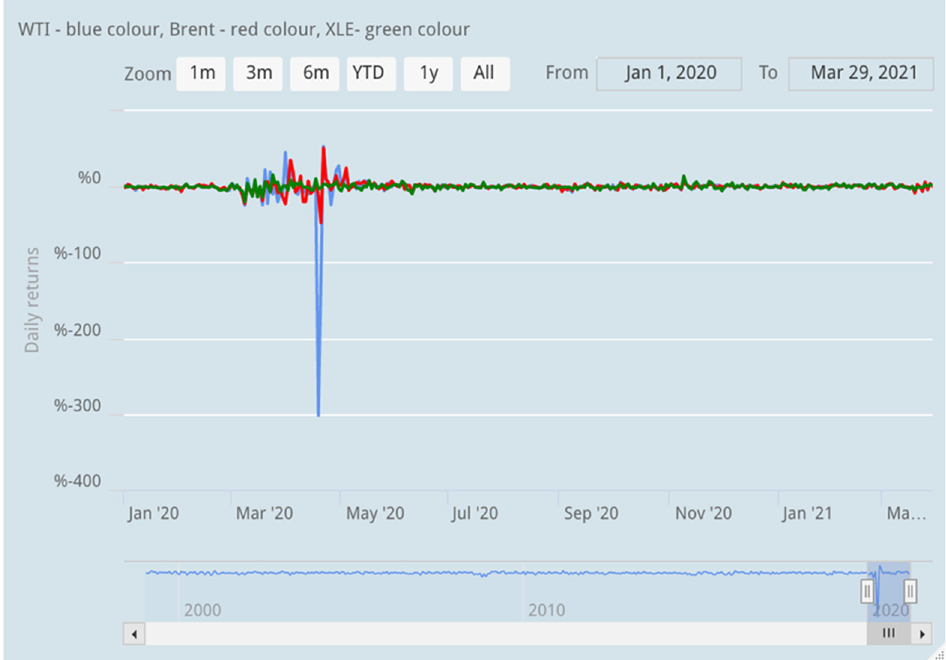
Figure 3. WTI, Brent Crude Oil and XLE Daily Returns during the COVID-19 pandemic (January